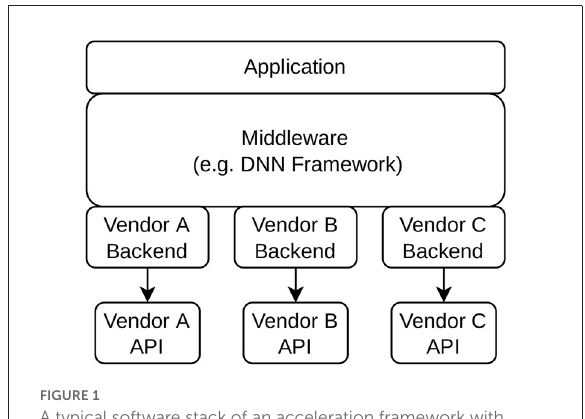
FIGURE1 A typical software stack of an acceleration framework with multiple vendor-specific backend implementations.